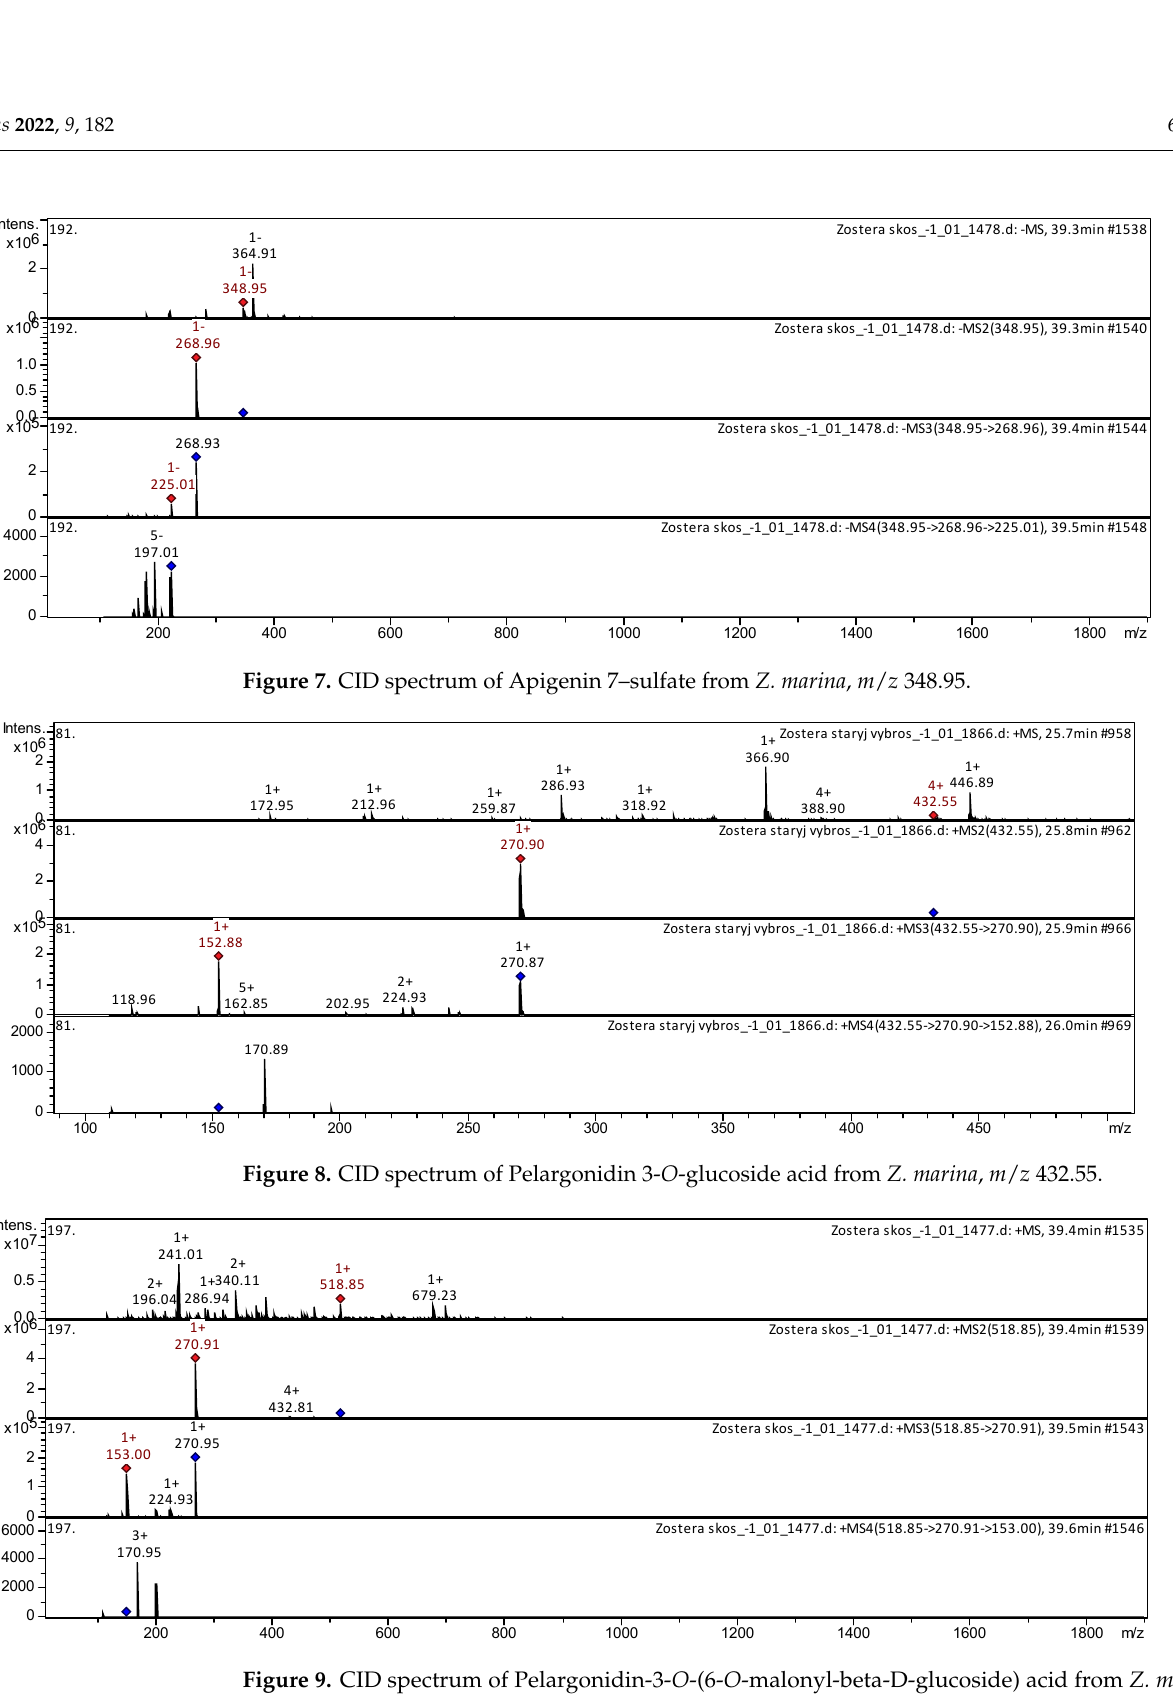
Separations 2022 , 9 , x FOR